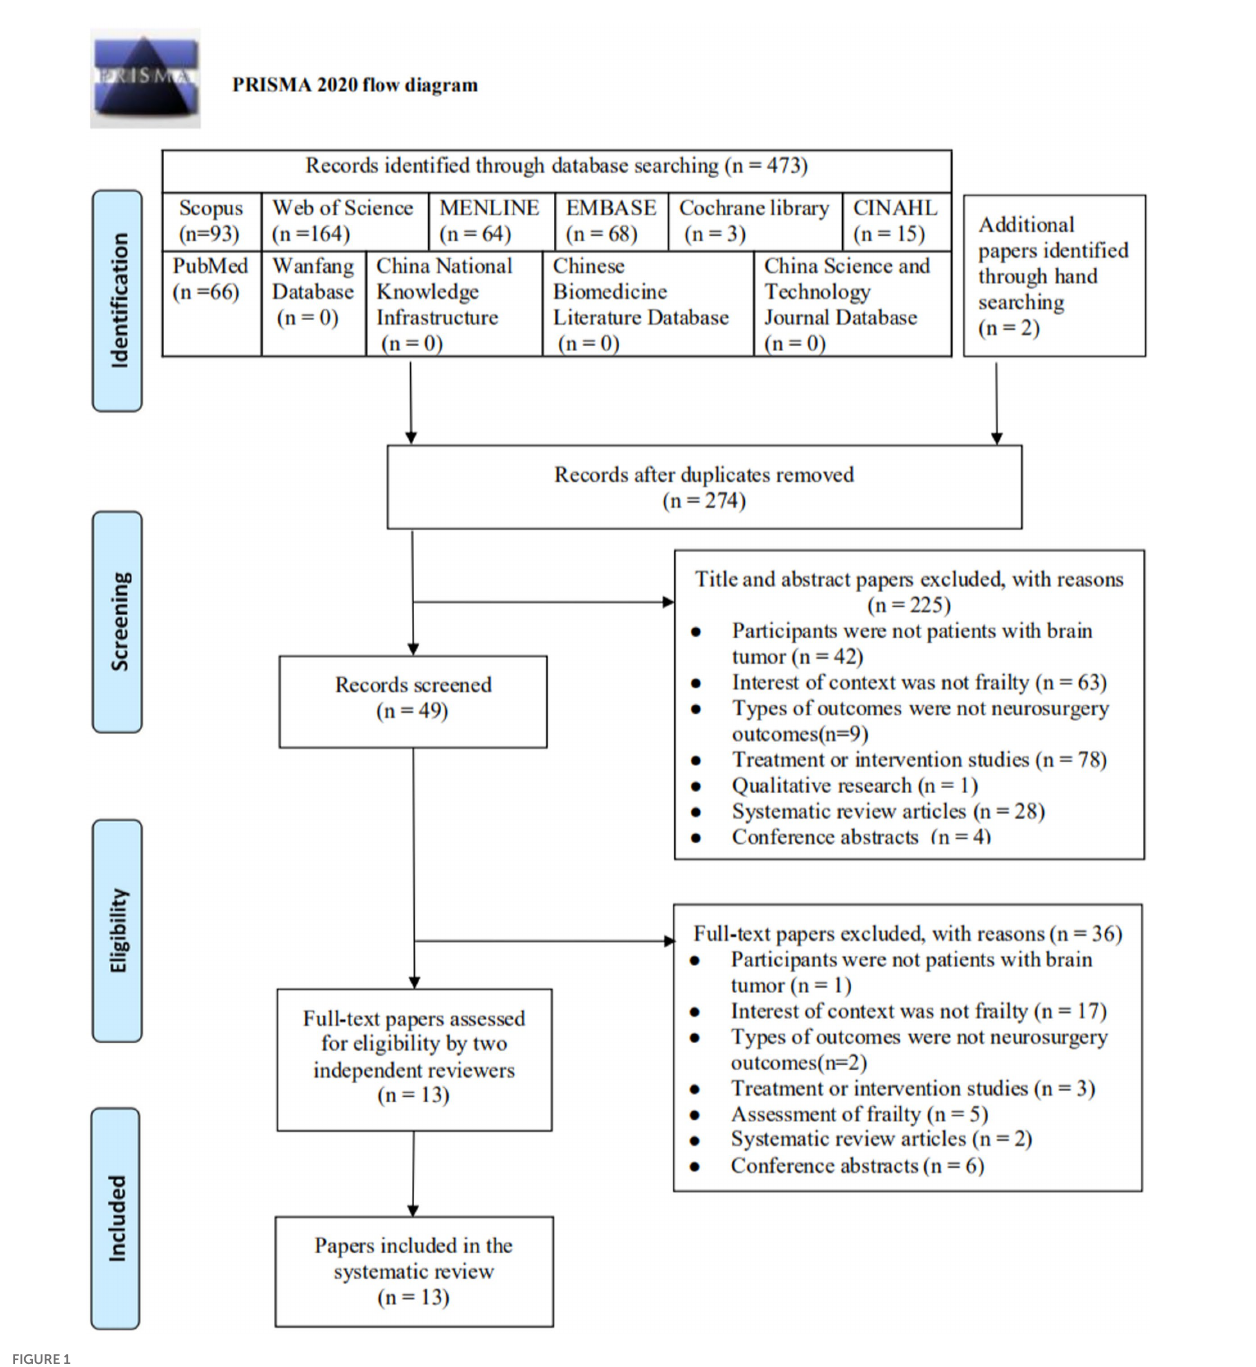
FIGURE 1 PRISMA flow diagram of literature search and study